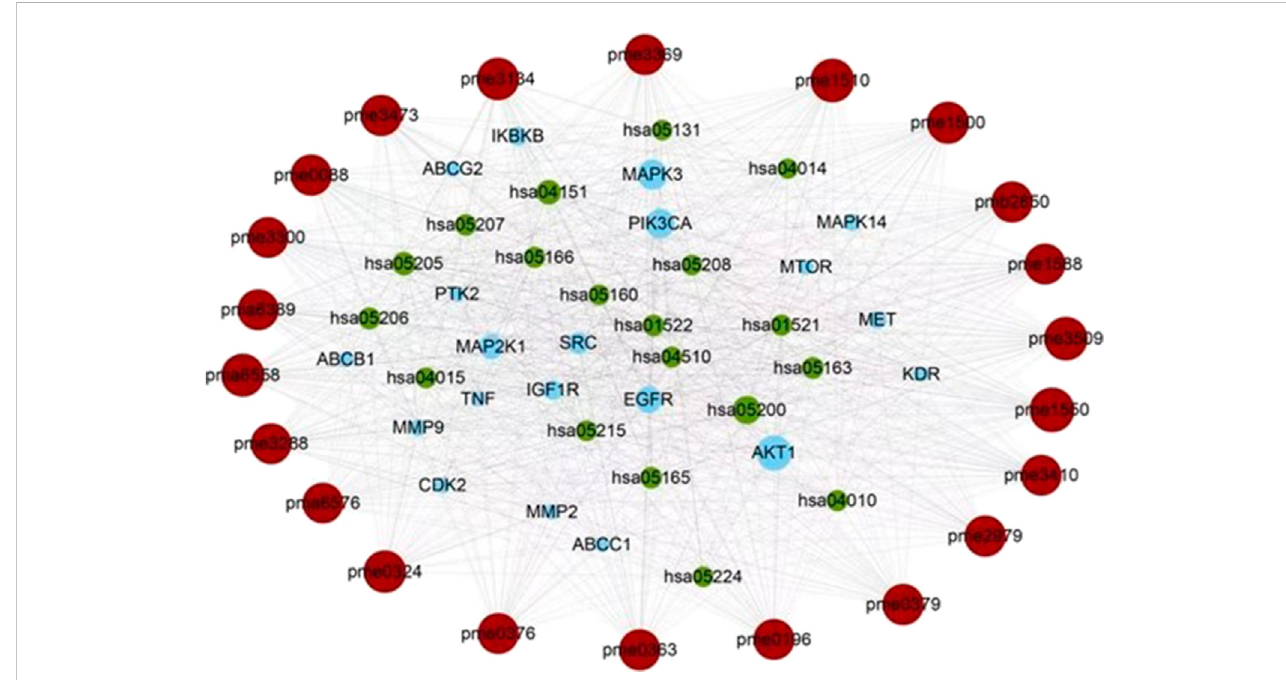
FIGURE 4 The core of the component-target-pathway network. Nodes fi lled with brown, blue, and green represent the active ingredients, targets, and pathways, respectively. The size of the node represents the degree value. Lines represent the relationships between the compounds, targets, and pathways.